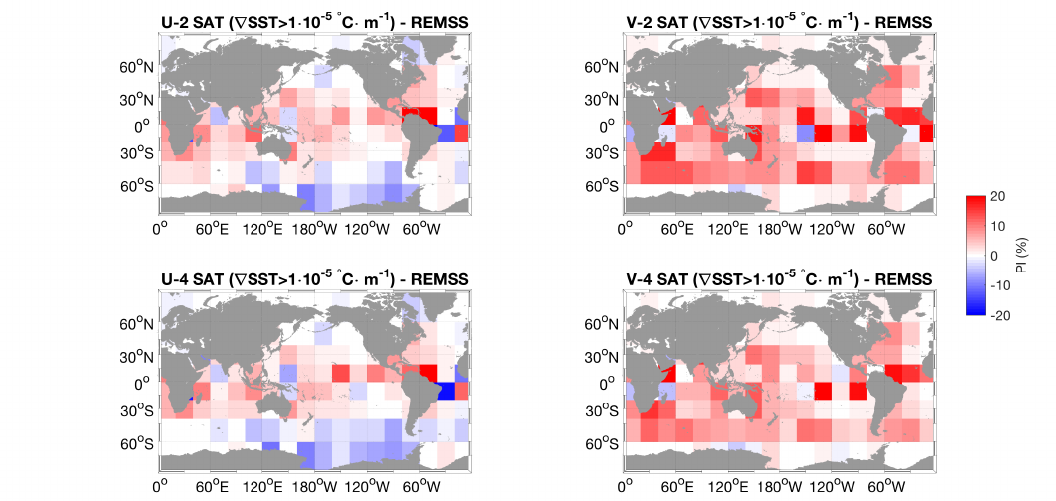
Figure 1. Percentage of Improvement (PI) (binned in 20 ◦ × 20 ◦ boxes) of the optimal current (OPC) with respect to the geostrophic estimates (over 2014–2016). Top row : OPC based on the DUACS “2SAT” currents. Bottom row : Optimal currents based on the Data Unification and Altimeter Combination System (DUACS) “4SAT” currents. The input Sea Surface Temperature (SST) is provided by Remote Sensing Systems (REMSS). U and V stand for zonal and meridional currents,